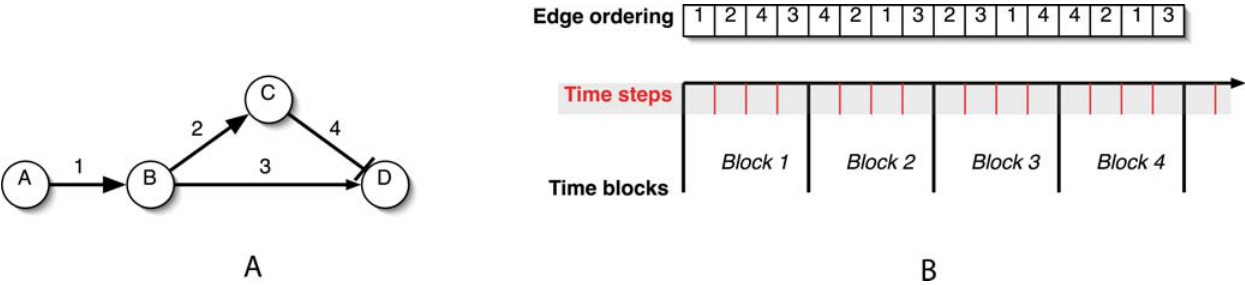
Figure 3. The Effects of Reaction Rates on Signal Propagation. (A) By changing the speed of signaling edge 3, the value of D at the end of a single simulation step can be reversed. If edge 3 is slower than the cascade B R C x D, then D will be active. If edge 3 is faster than the cascade, then D will be inactive. (B) An example of how the simulator might evaluate the individual edges during a run. In each time block, every edge is evaluated once. Each edge evaluation corresponds to one time step. Note that the order of the edge evaluation is shuffled during each time block in order to sample the space of possible relative signaling rates.